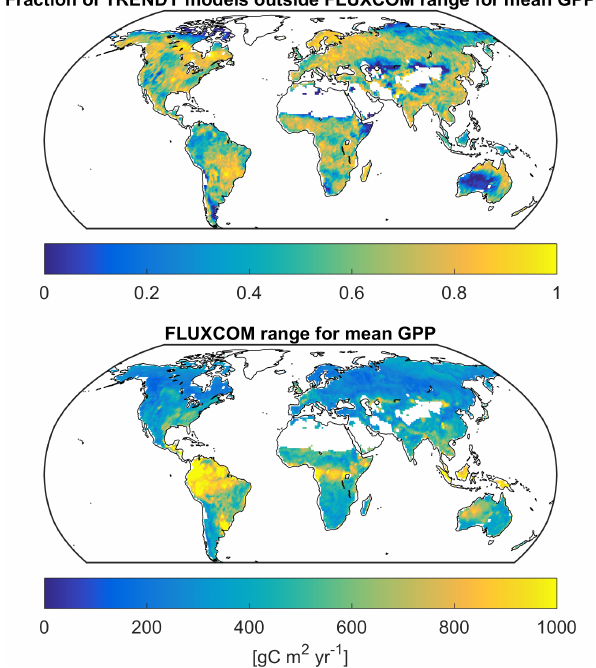
Figure 3. Map of the fraction of TRENDY models ( n = 16) with mean GPP outside the range of FLUXCOM estimates. The FLUX- COM range is calculated as the maximum minus minimum of all 48 FLUXCOM members from the union of the RS and RS + METEO members. Mean GPP was calculated for the period